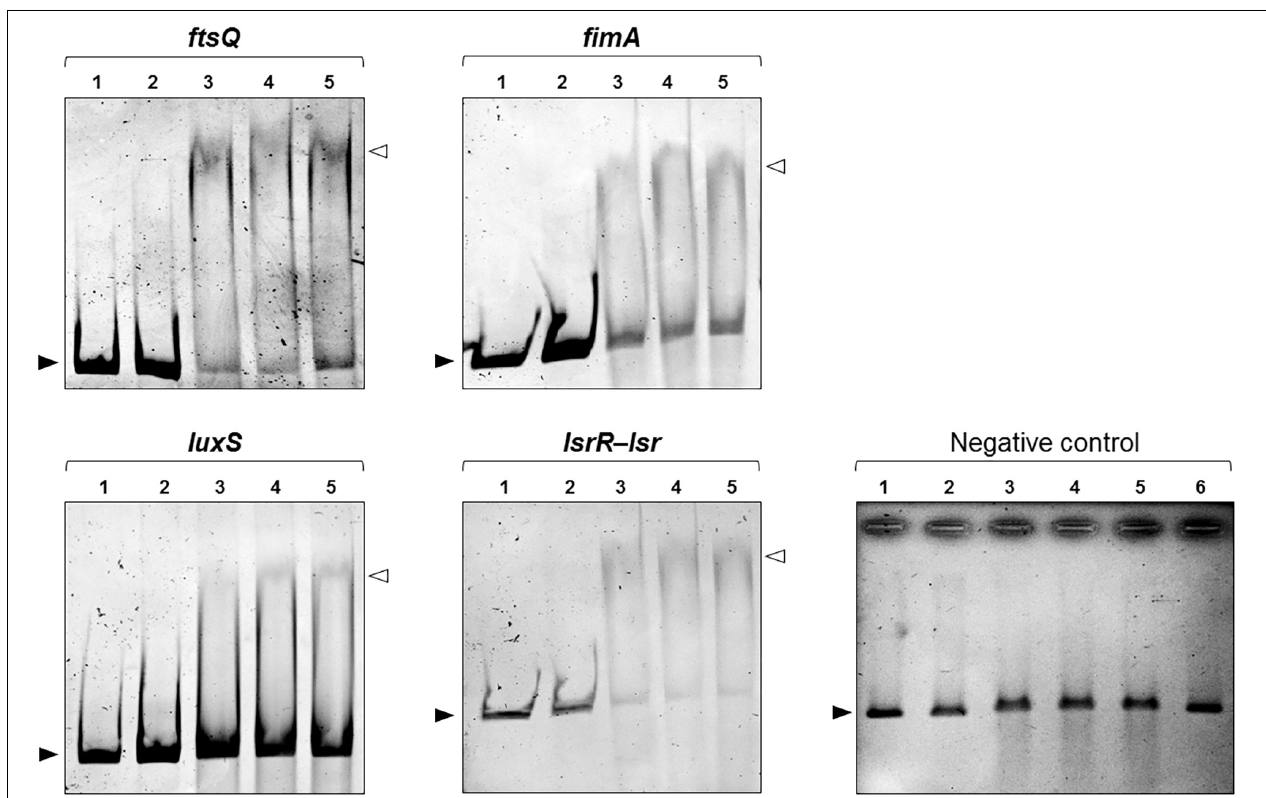
FIGURE 6 | DNA Electrophoretic Mobility Shift Assays (EMSA) revealed that SdiA binds to the promoter region of ftsQ , fimA , and the intergenic region between the lsrR and lsr operon. For EMSA, 50 η g of the DNA probes (in all lanes) were incubated with 2 ρ moles (lane 2) or 10 ρ moles (lanes 3–5) of the recombinant His-SdiA protein for 30 min at 37 ◦ C. To investigate the effects of AHL on the binding affinity of SdiA, 2 µ M (lane 4) or 4 µ M (lane 5) of C8-HSL were added to the binding reaction. Mobility shifts (indicated by open arrowheads) are observed only at higher concentration of purified SdiA (10 ρ moles, lanes 3–5). These shifts represent the formation of SdiA-DNA probe complexes and confirm the binding activity of SdiA on the DNA probes. The addition of C8-HSL have no apparent effect on the shifting mobility of the bands (lanes 4 and 5 compared). Closed arrowheads indicate the free DNA probes. No shifted bands were observed when SdiA was incubated with the negative control DNA probe. Lane 6 represents the incubation of the negative DNA probe (50 η g) with 4 µ M of C8-HSL in the presence of 10 ρ moles of the purified